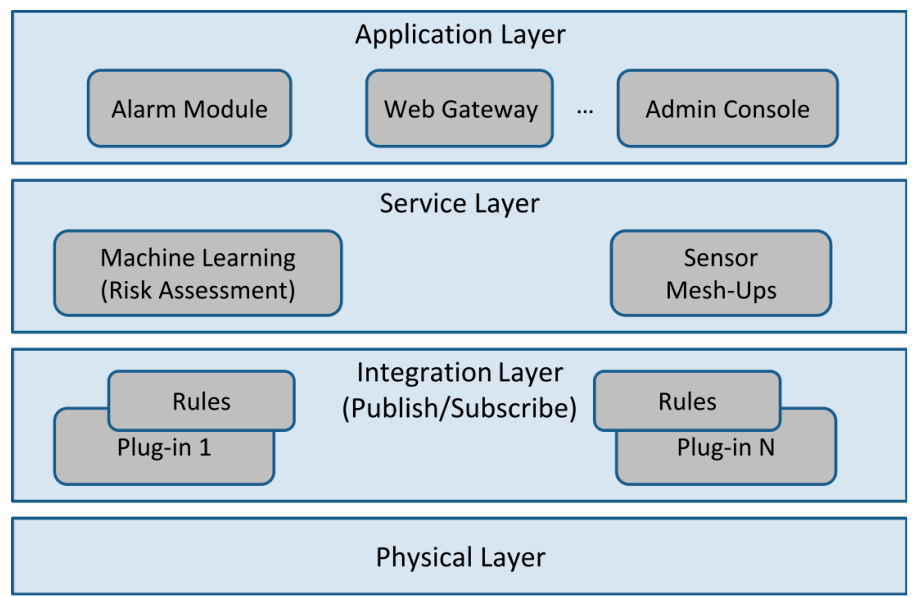
Figure 1. The AISH system